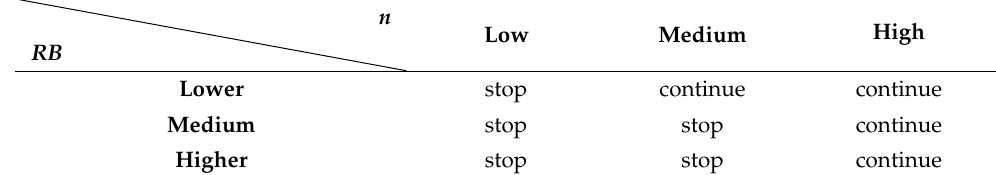
Table 1. Fuzzy rule base.